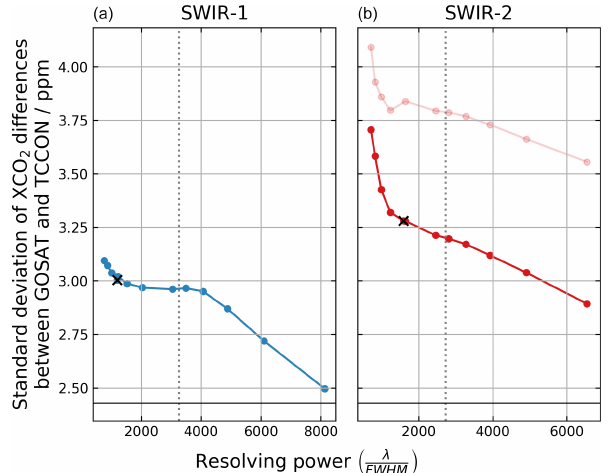
Figure 3. Standard deviation of retrieved XCO 2 values in SWIR- 1 (a) and SWIR-2 (b) around TCCON measurements plotted as a function of resolving power. For SWIR-2, the faint line indicates scatter for a non-scattering retrieval. The dotted line marks the re- solving power at which spectral lines become indistinguishable in the convolved spectra. The black horizontal line indicates the native GOSAT scatter around TCCON. The × marks the resolving power that we study in the rest of the